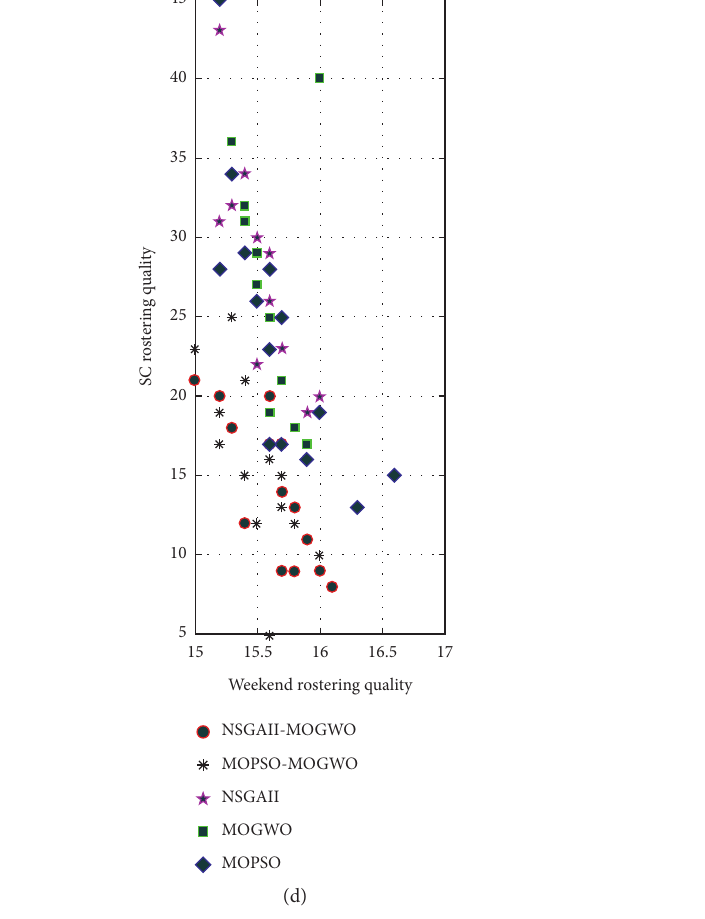
Figure 2: Comparison results of four algorithms for MLNRP. (a) Nondominant solutions. (b) Nondominant solution in 2D. (c) Non- dominant solution in 2D. (d) Nondominant solution in